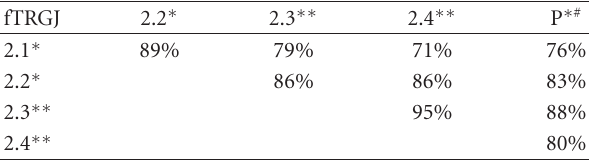
Table 2: Nucleotide homology of feline J-region